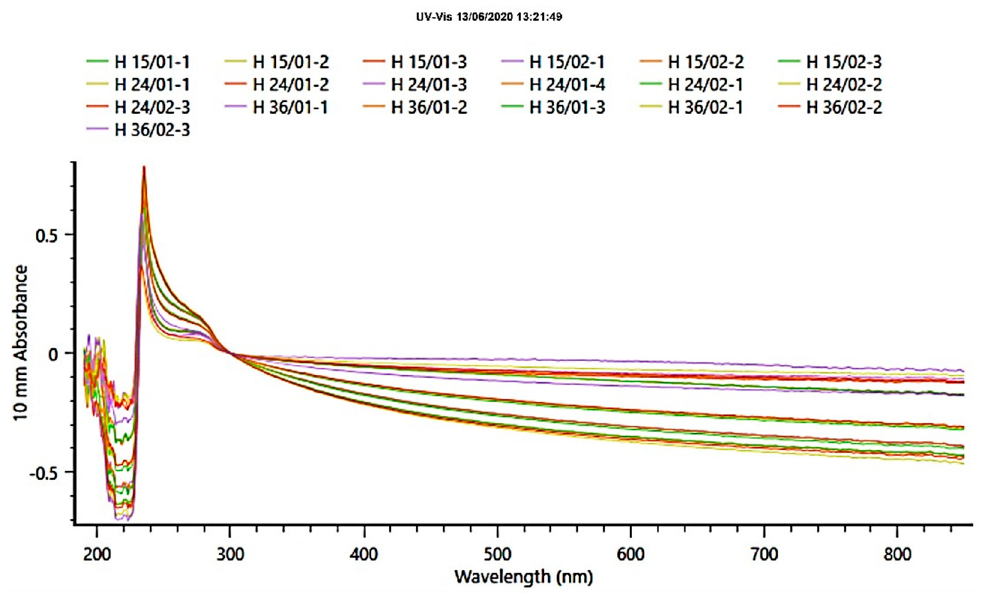
Figure 5. UV absorption spectrum of Oreochromis niloticus “tilapia” skin collagen samples (9 months old). ( A ). Red ASC (233 nm); ( B ). Gray ASC (234 nm); ( C ). F1 ASC (233 nm); ( D ). Red PSC (233 nm); ( E ). Gray PSC (234 nm); ( F ). F1 PSC (232 nm). ( G ): UV-visible spectrum of collagen from F1 (H) aged: 15, 24 and 36 months old.